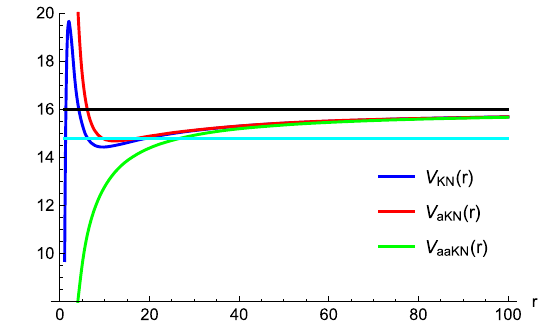
Fig. 12 (Left)potential V KN ( r ) anditsasymptoticpotentials V aKN ( r ) and V aaKN ( r ) as functions of r ∈ [ r + = 1 . 062 , 100 ] with M = 1 , Q = 0 . 01 ,ω = 3 . 85 , a = 0 . 998 , m = 13 , q = 0 ,λ lm = 180 ,μ = 4. V KN ( r → r + ) is 9.72 and a trapping well is located at r = 9 . 6. We note ω < ω = 6 . 11 and ω < μ as the condition for superradiant c